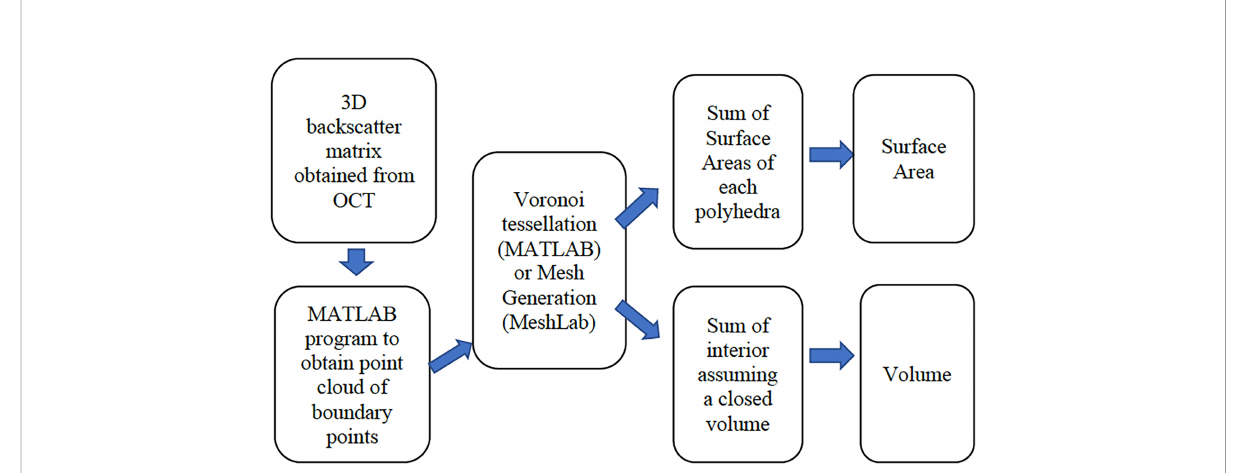
FIGURE 1 An overview of the processing algorithms indicating the input of OCT data, the computation of boundary points, the mesh generation or Voronoi tessellation, and the surface area and volume